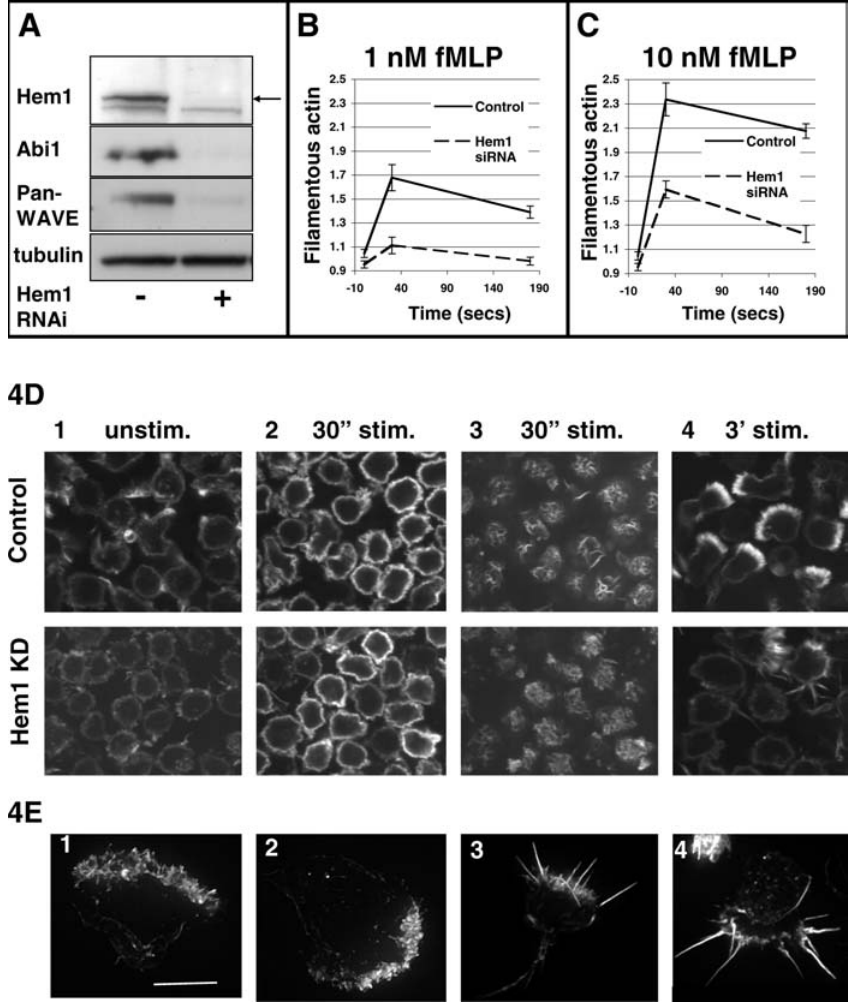
Figure 4. Actin Polymerization and Polarity Are Dependent on Hem-1 (A) RNAi-mediated inhibition of endogenous Hem-1 protein expression and degradation of WAVE complex proteins in HL-60 cells. Whole cell lysates were prepared from control cells and siRNA-expressing cells as described. Equal amounts of lysate were used to determine expression of Hem-1, Abi-1, and pan-WAVE by Western blotting. Tubulin levels are shown as a loading control. (B, C) Actin polymerization is dependent on Hem-1. Differentiated HL-60 cells were treated with or without 1 nM fMLP (B) or 10 nM fMLP (C) for 30 s or 3 min, as indicated. After fixation, F-actin content was assessed by staining with Alexa647-conjugated phalloidin and quantified by FACS analysis. Absolute actin levels are shown for each condition (averages of control and Hem-1 knockdown cell Alexa 647 staining was used to normalize for FACS variation and staining intensity between experiments). Standard error of mean for six experiments is shown. (D) Cell polarity is dependent on Hem-1. Control and Hem-1 knockdown cells were stimulated in suspension with or without uniform fMLP (20 nM final concentration) for 30 s or 3 min, fixed and stained with rhodamine phalloidin to visualize filamentous actin, and visualized with spinning disk confocal microscopy. Unstimulated cells are nonpolar with minimal filamentous actin accumulation (1). Both control and knockdown cells uniformly